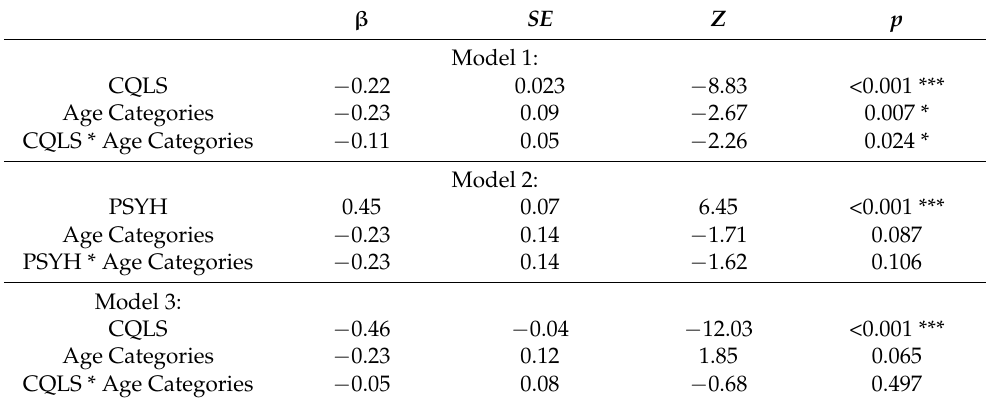
Table 3. Moderation